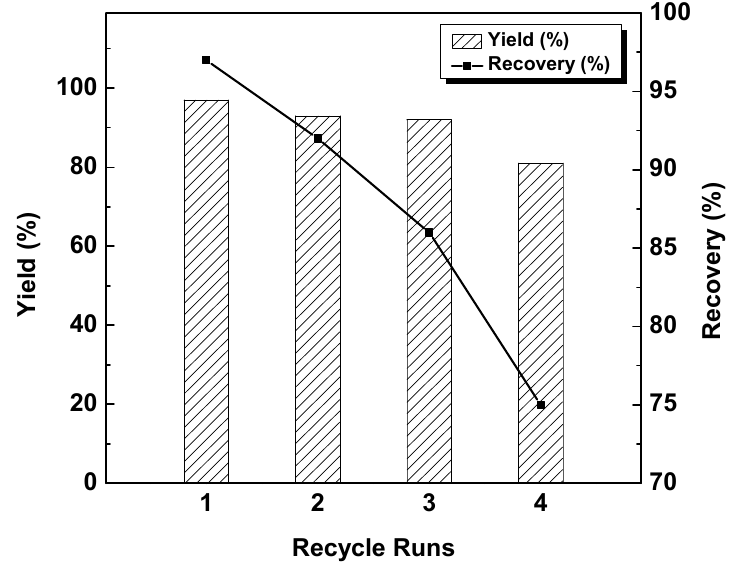
Catalysts 2019 , 9 , x FOR PEER REVIEW Figure 5. Catalyst recycling test in dioxane of Au-SiO 2 @Fe 3 O 4 -RGO. Figure 5. Catalyst recycling test in dioxane of Au-SiO 2 @Fe 3 O 4 -RGO.